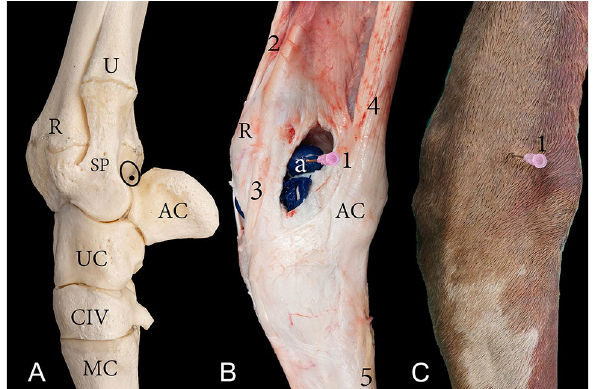
Figure 8. Lateral view of a left carpal joint providing orientation for the arthrocentesis approaches through three different types of specimens: ( A ) bones, ( B ) dissected, and ( C ) intact. R, the distal end of the radius; U, the distal end of the ulna; SP, lateral styloid process; AC, accessory carpal bone; UC, ulna carpal bone; CIV, carpal bone IV; MC, metacarpal bone; a, lateropalmar pouch of the radiocarpal joint; 1, the lateral approach of the radiocarpal joint; 2, extensor carpi radialis tendon; 3, lateral digital extensor tendon; 4, extensor carpi ulnaris tendon. The circle and black dot in ( A ) indicate the injection site to the lateropalmar pouch located in the impression formed between the lateral styloid process and the accessory carpal